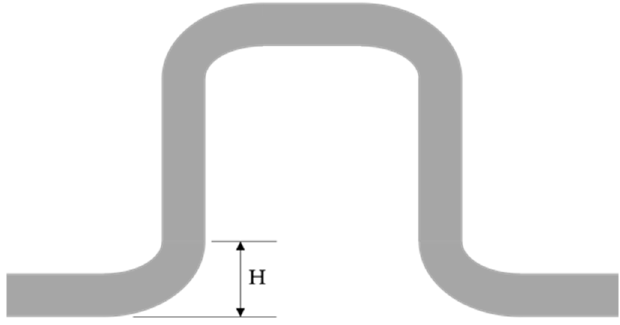
Figure 18. Piping arrangement taking into account stress analysis.